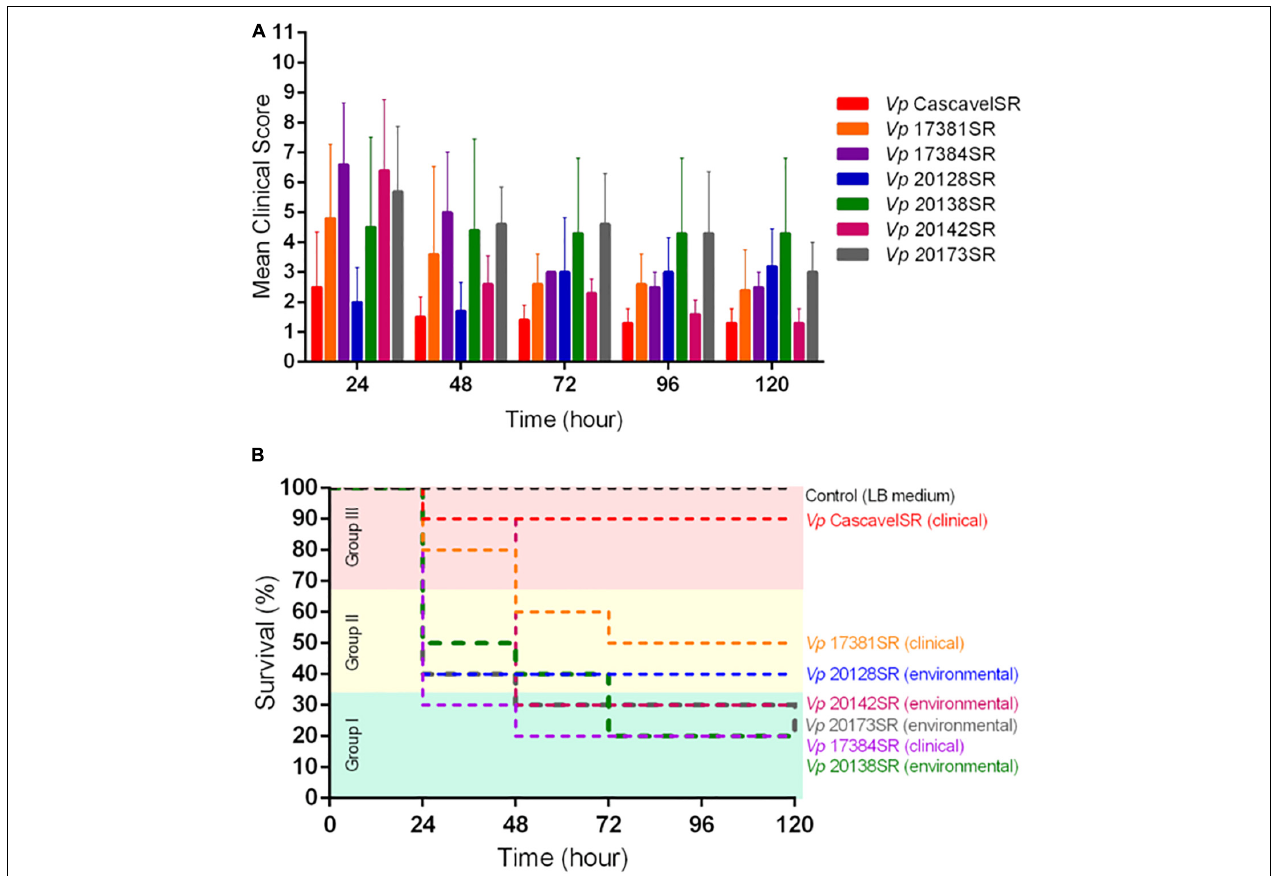
FIGURE 1 | Mean clinical scores (A) and survival curves (B) of mice inoculated with each of the seven Vibrio parahaemolyticus strains at a dose of 10 8 CFU/animal. Eleven clinical signs were evaluated every 24 h for 120 h post-infection, in groups of n = 10 animals per dose of each strain. Control group: mice inoculated with LB medium, n = 5 animals. Strains were grouped according to virulence: group I (green) – high; group II (yellow) – intermediate; and group III (red) – low. Survival curves of mice in each group were generated using the Kaplan–Meier method (Kaplan and Meier, 1958) and compared using the log-rank test (Mantel, 1966; Peto and Peto, 1972), with p -values < 0.05 considered statistically